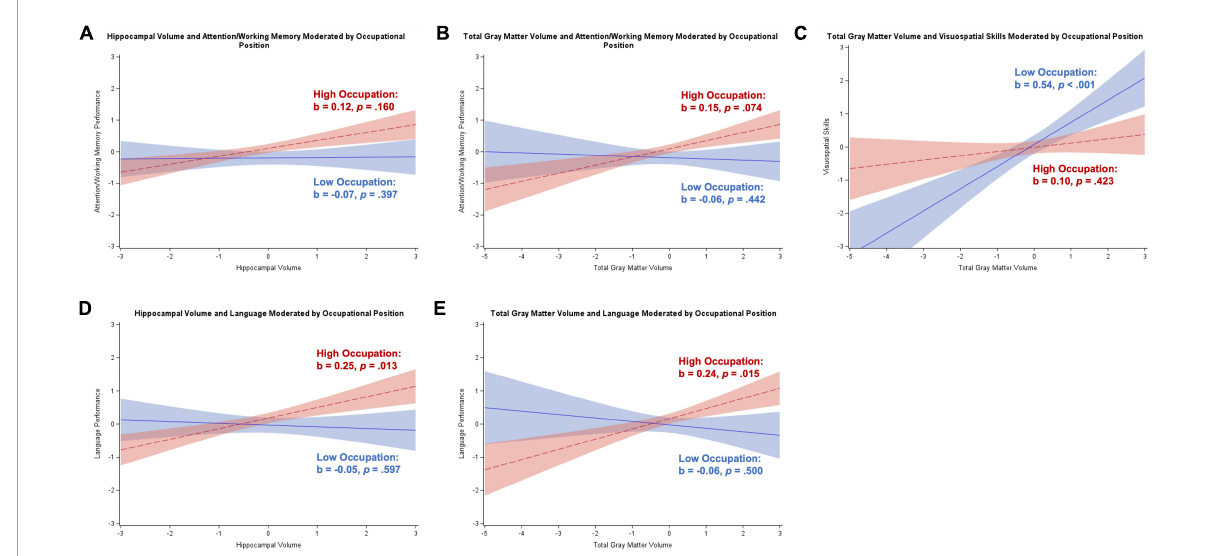
FIGURE4 Plots of significant moderations by occupational position of the associations between brain volume and cognition for participants with subjective cognitive decline. High occupational position corresponds to 1 SD above the mean and low occupational position corresponds to 1 SD below the mean. The red dotted line represents high occupational position, and the blue solid line represents low occupational position. Shaded areas represent 95% confidence intervals. Cognition and brain volume were standardized. (A) Non-significant positive association between hippocampal volume and attention/working memory for participants with high occupational position; non-significant negative association for low occupational position. (B) Non-significant positive association between total gray matter volume and attention/working memory for participants with high occupational position; non-significant negative association for low occupational position. (C) Non-significant positive association between total gray matter volume and visuospatial skills for participants with high occupational position; significant positive association for low occupational position. (D) Significant positive association between hippocampal volume and language for participants with high occupational position; non-significant negative association for low occupational position. (E) Significant positive association between total gray matter volume and language for participants with high occupational position; non-significant negative association for low occupational